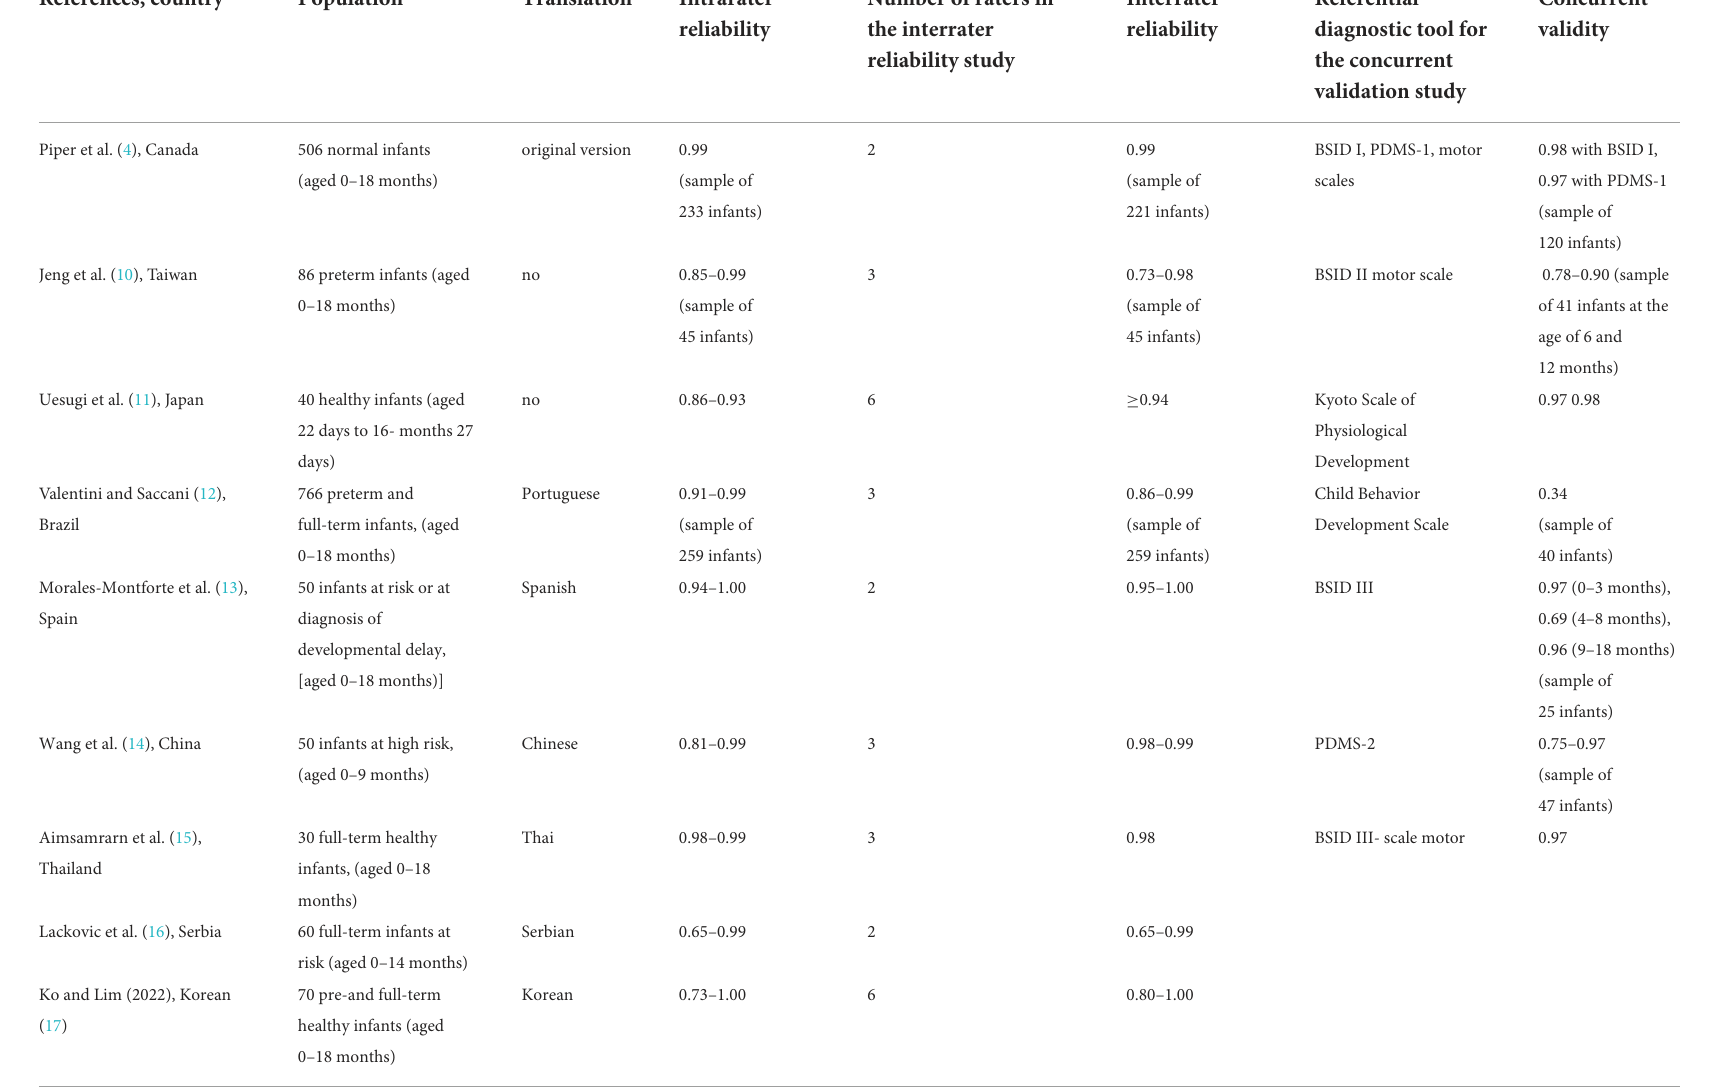
TABLE 1 The studies on the reliability and validity of the